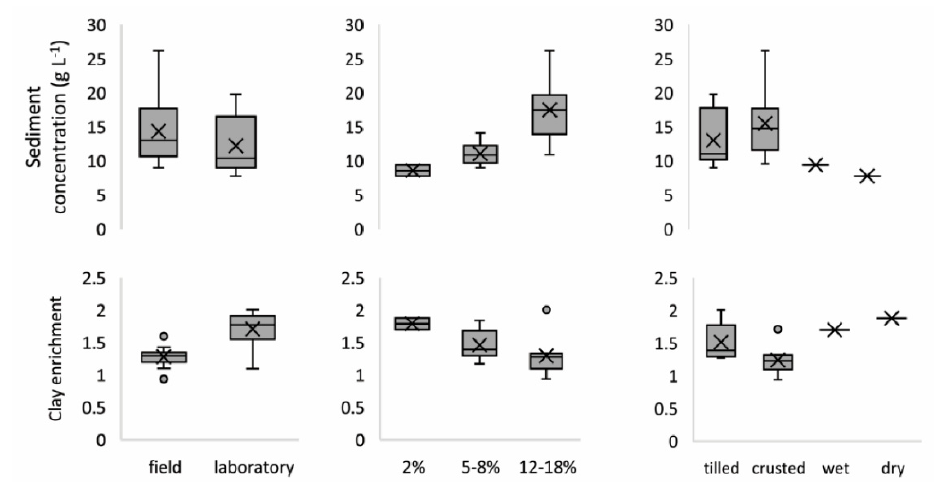
Figure 5. Comparison of the sediment concentration and clay enrichment in relation to the location, slope gradient, and surface properties. The most striking differences were caused by the slope gradient, and the SC increased while the CE decreased with an increasing slope gradient.